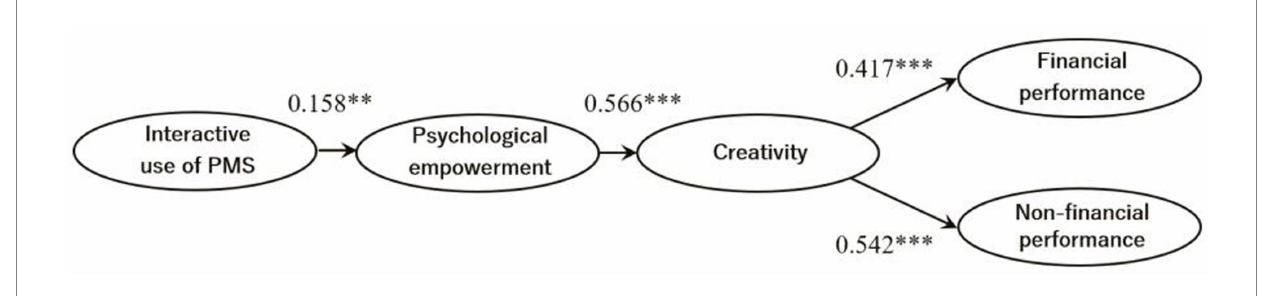
FIGURE 1 Final structural model. Paths of the control variables are omitted for clarity. Significant relationships are in bold. *** p < 0.01, ** p < 0.05.